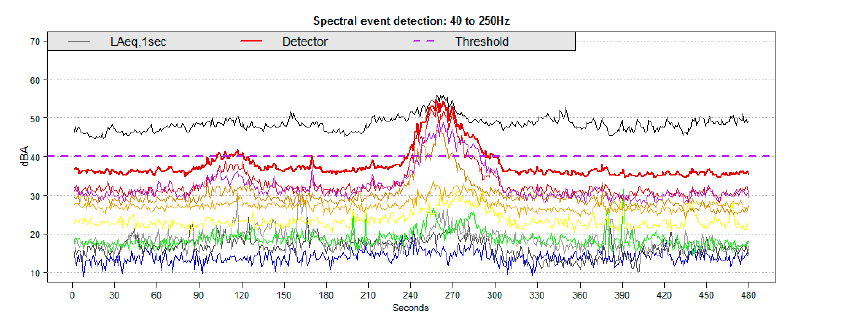
Figure 3. Time series of a standard event with L Amax of 65 dBA that could/should be detected with ISO 20906:2009; the detector threshold is set to 52 dBA, showing L Aeq,1sec , the detector and the detection threshold (40 dBA). The third-octave bands used in the detector are also shown (40–250 Hz). Higher- frequency bands are attributed significantly to the aircraft sound exposure level